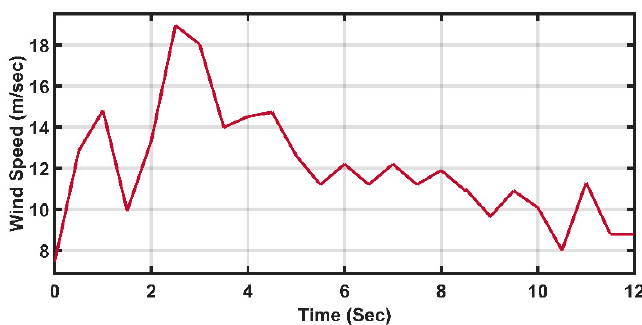
Energies 2021 , 14 , x FOR PEER REVIEW Table 9. Statistical analysis of the active power—normal fourth case. Table 9. Statistical analysis of the active power—normal fourth case.